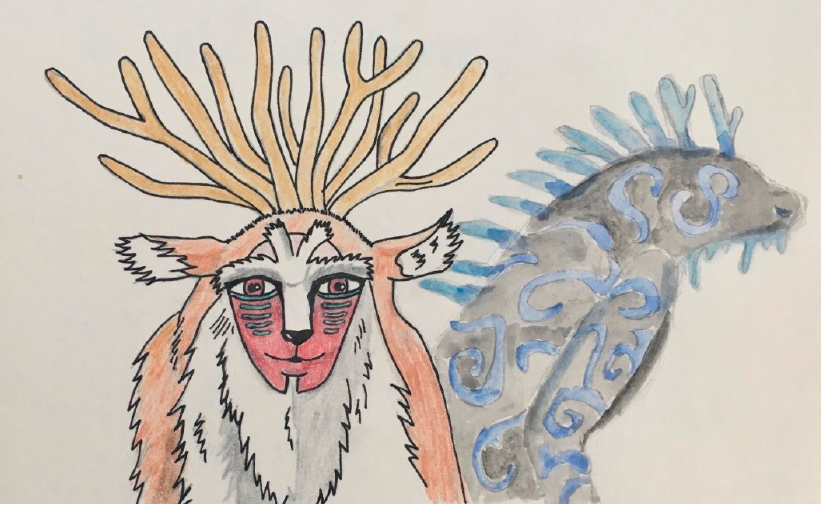
Figure 5. The Forest Spirit (Shishigami) and the Night Walker, which the forest spirit transforms into at night, as depicted in Princess Mononoke (1997).